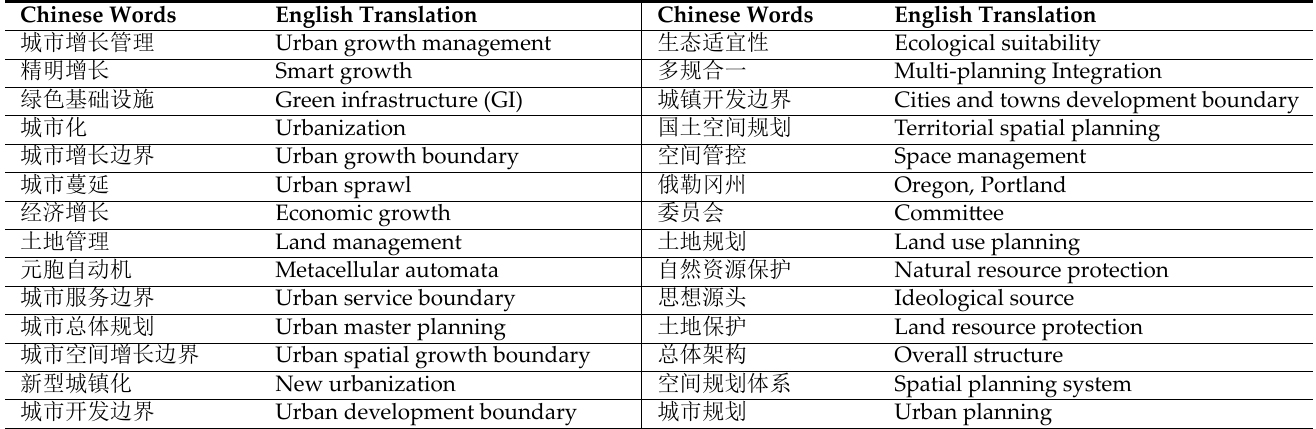
Table A1. English translation corresponding to Chinese